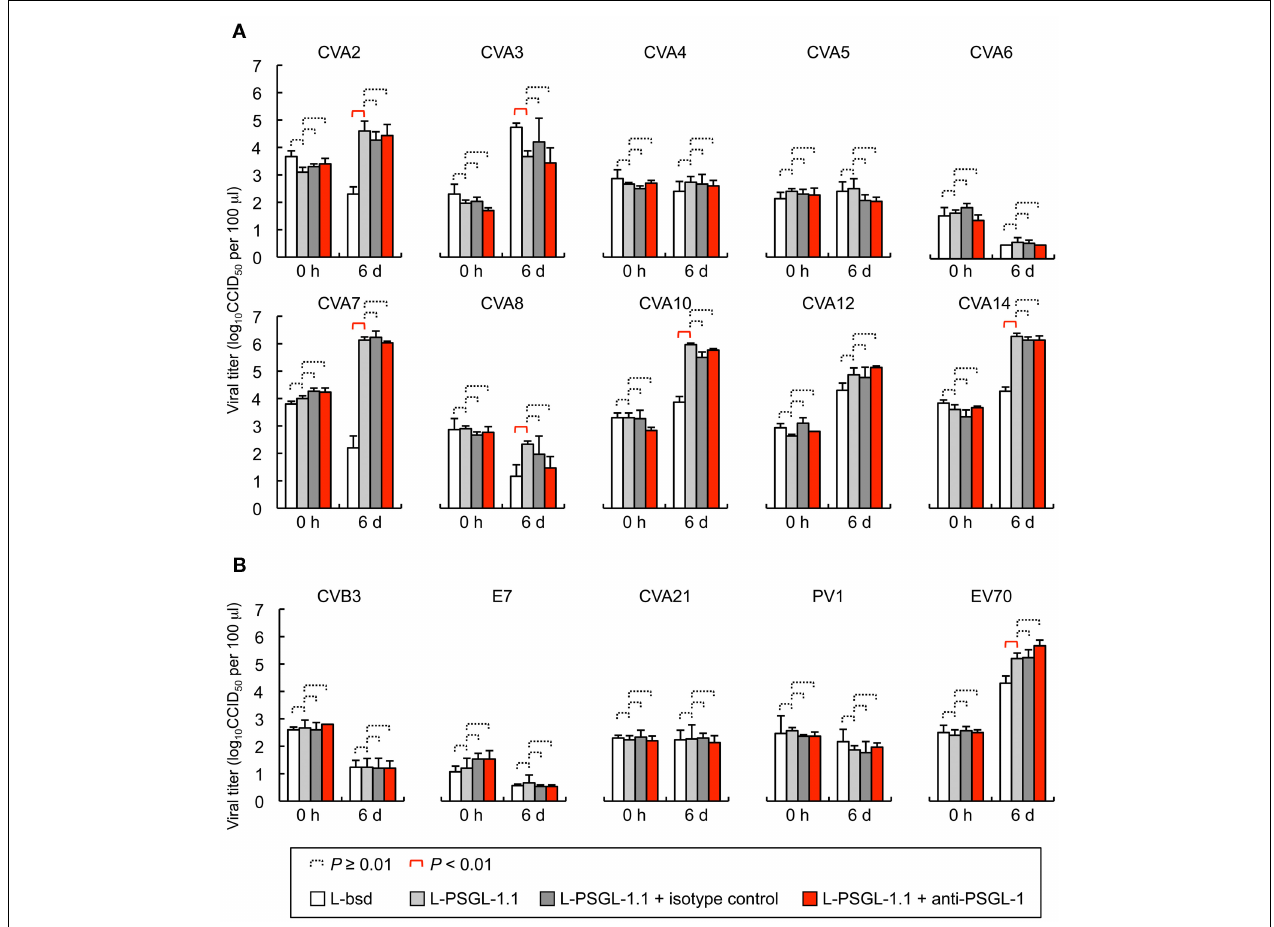
FIGURE 1 | Human enteroviruses replication in L-PSGL-1.1 cells. (A) Replication of the HEV-A strains ( Table 1 ) in L-PSGL-1.1 cells in the presence or absence of anti-PSGL-1 mAb (KPL1) or an isotype control. Cells were inoculated with viruses at 10 CCID 50 /cell for 1h, washed, and incubated in the medium, as described previously (Nishimura et al., 2009). Cells were incubated at 34˚C. For mAb inhibition, the cells were pretreated with 10 μ g/ml mAb for 1h, washed, and maintained in the medium with 10 μ g/ml mAb. At the indicated time [just after infection (0h) and 6days postinfection (6d)], the infected cells and supernatants were freeze-thawed and viral titers were determined by CCID 50 titration using RD cells.The titers are expressed as the